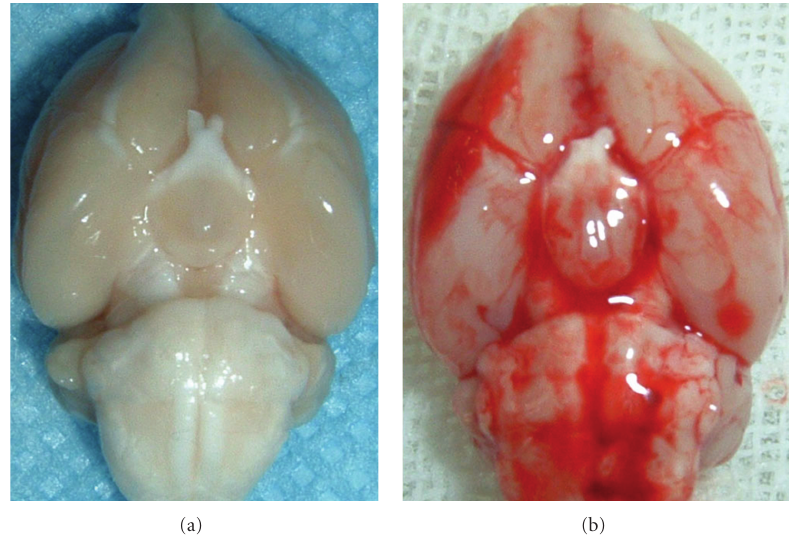
Figure 1: Schematic representation of the areas taken for assay. (a) Control rat brain; (b) SAH rat brain.